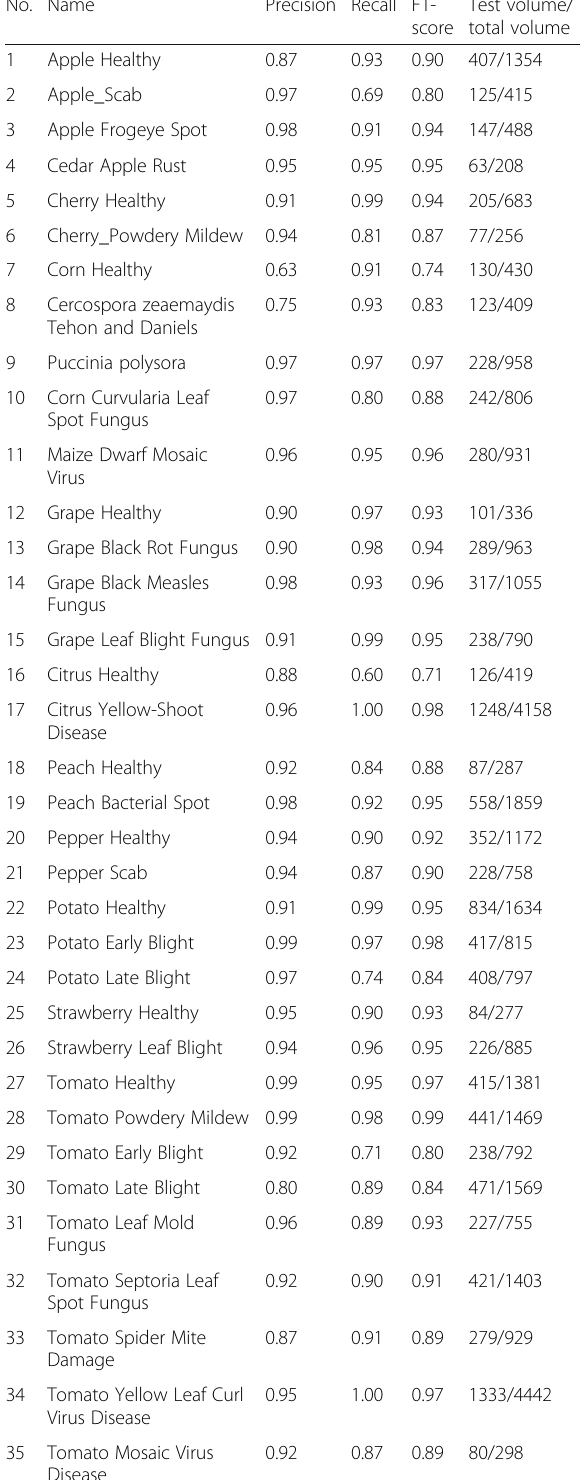
Table 3 Experimental results on testing WRN